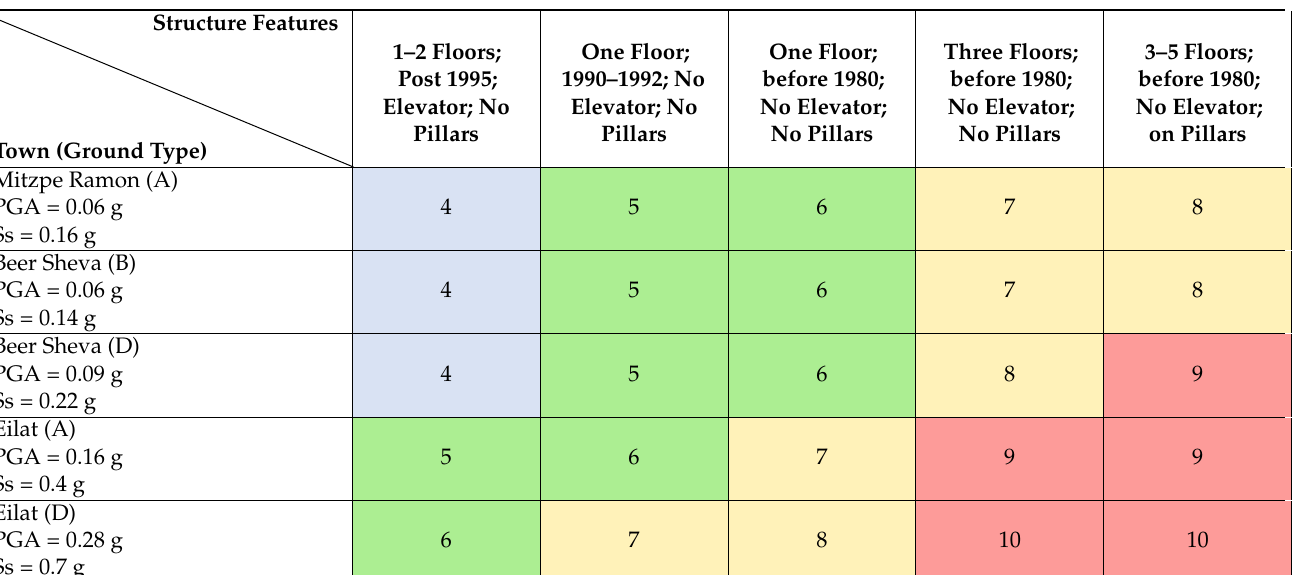
Table 2. Modified Mercalli Intensity (MMI) damage intensity calculated for six typical building types in Mitzpe Ramon and two cities in southern Israel. The colors emphasize the degree of risk: blue (low); green (medium), yellow (high) and red (very high). Modified from Finzi et al., 2019 [41]. PGA is peak ground acceleration, Ss is the spectral acceleration for short